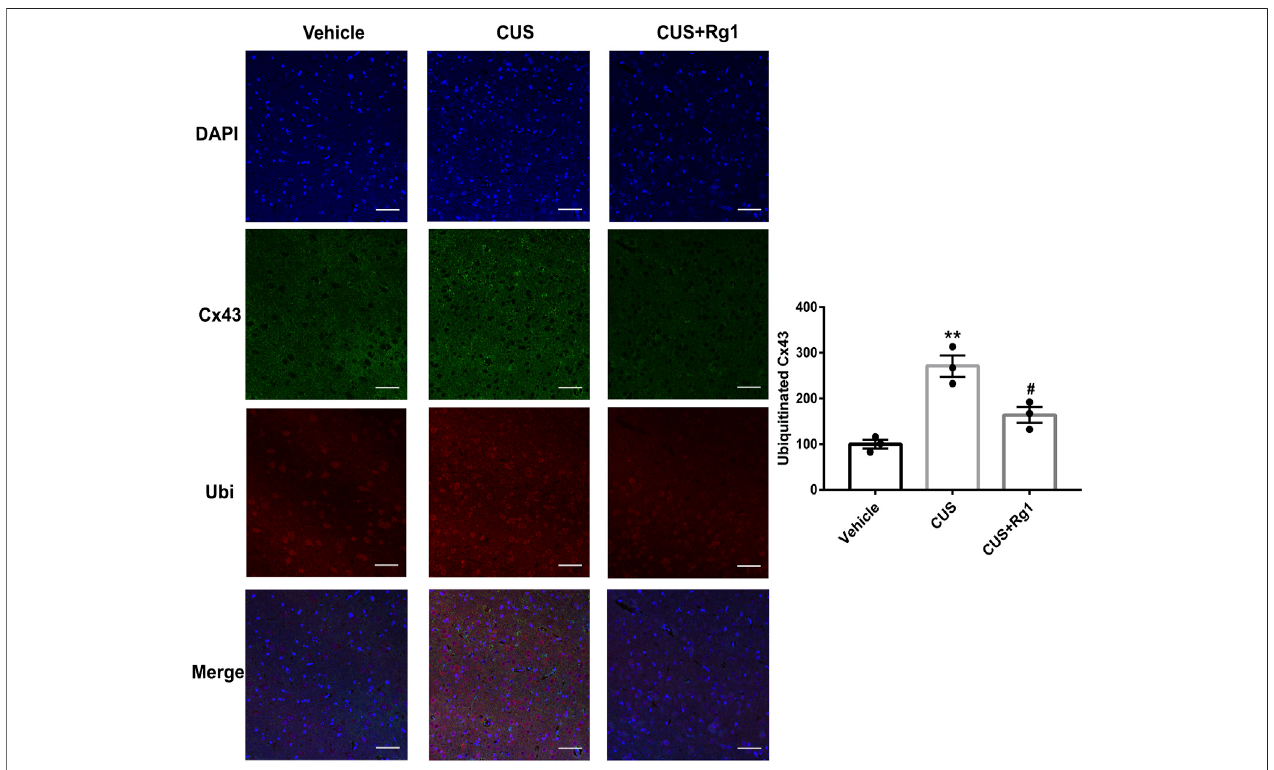
FIGURE5| Rg1decreasesubiquitinatedCx43inCUS-treatedrats.Theconfocalmicroscopyimagesshoweddouble-stainedwithantibodiesagainstCx43(green) and ubiquitin (red). Nuclei are stained with DAPI. Scale bar (cid:1) 150 μ m. n (cid:1) 3 per group. ** p < 0.01, compared with the vehicle group; # p < 0.05, compared with the CUS group. Ubi,